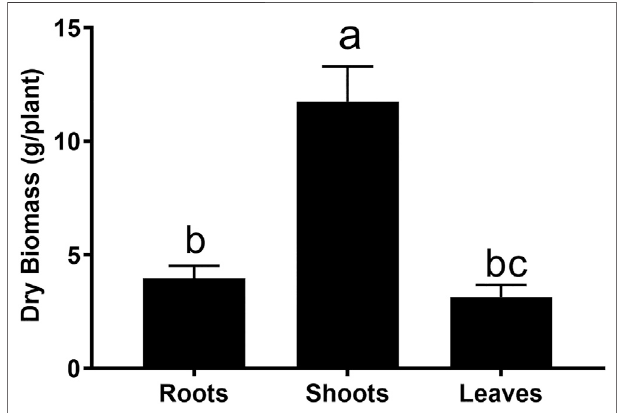
FIGURE 1 | Comparative dry biomass of different parts of G. uralensis . Small letters represent level of signi fi cance among different treatments as inferred by DNMRT at p (cid:1)